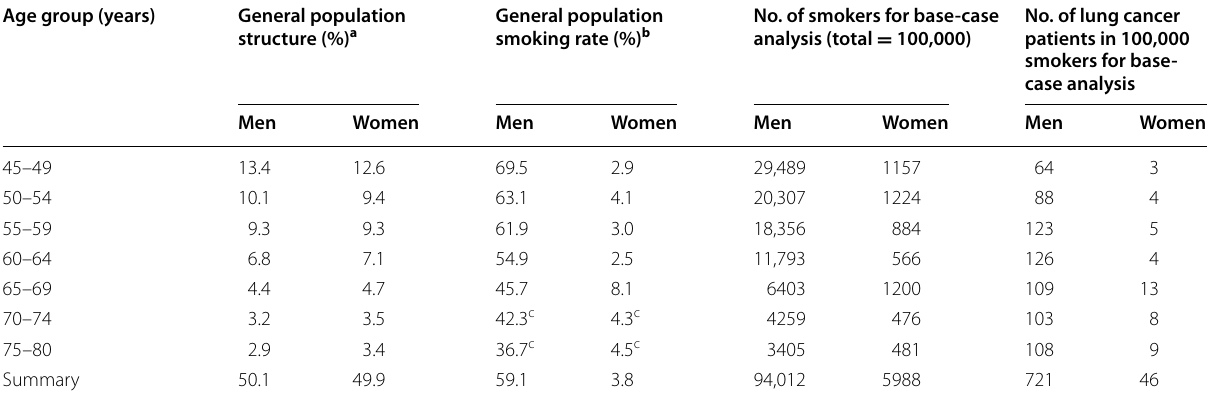
a Obtained from Sampling Survey Data of the National Population Change in 2013 in China Population & Employment Statistics Yearbook [18] b Obtained from Global Adult Tobacco Survey (GATS) China 2010 Country Report [26] c Predicted using linear